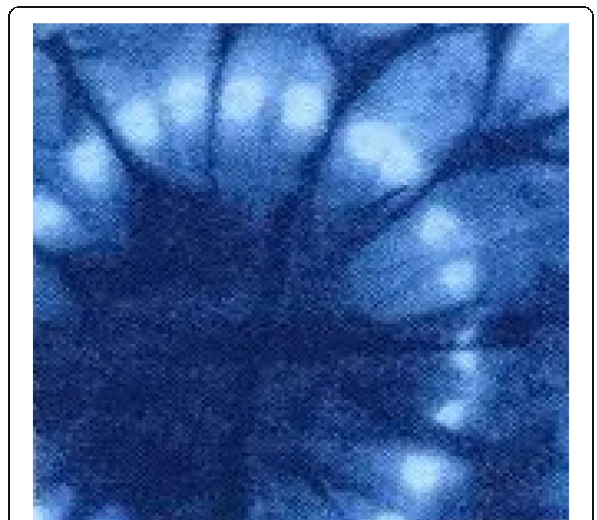
Fig. 1 Traditional flat seam tie-dyeing process [7]